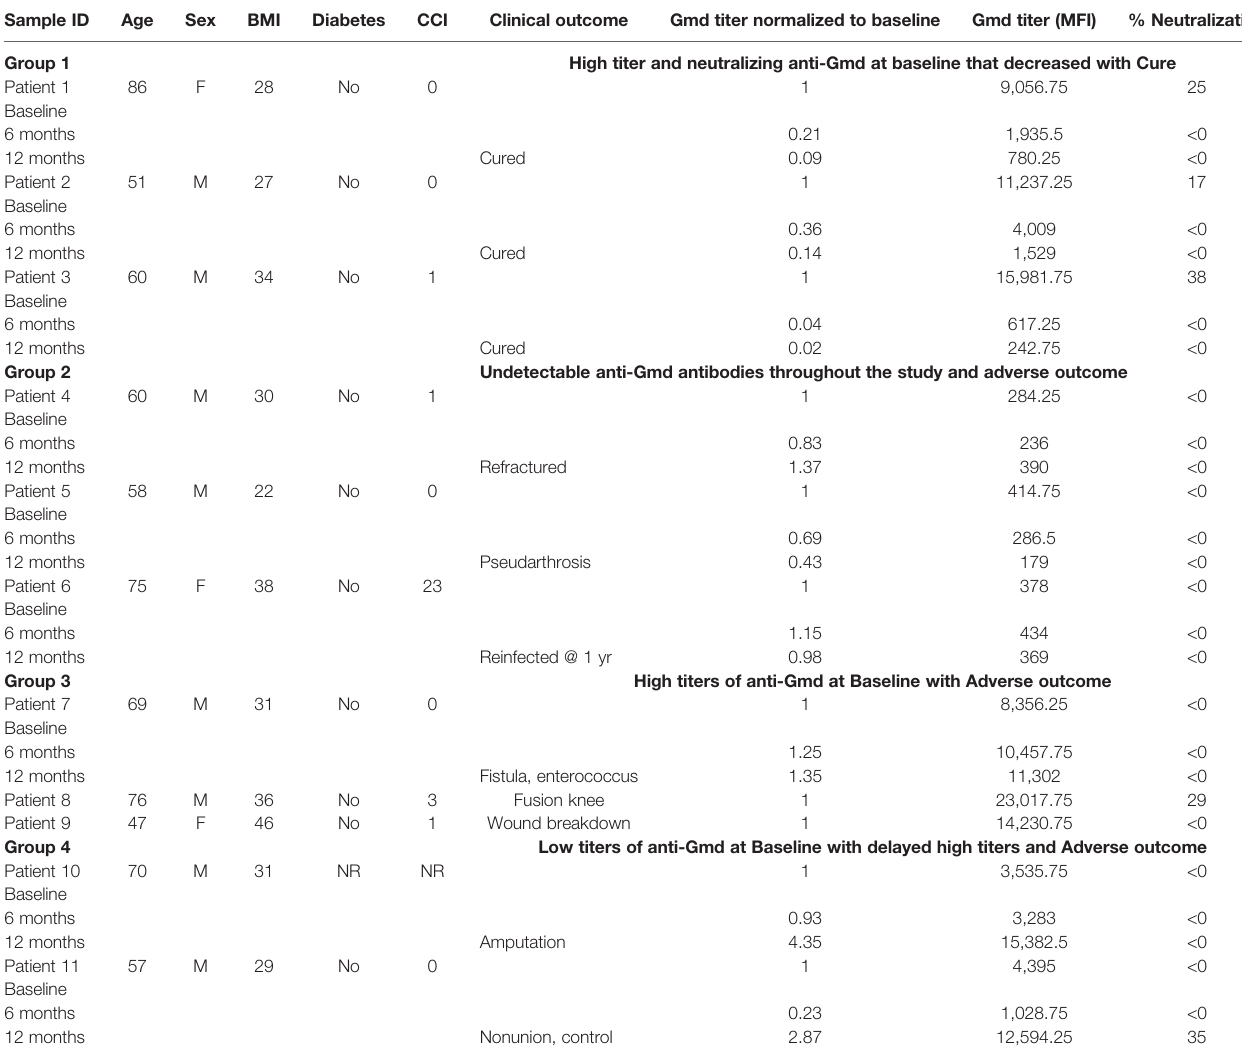
TABLE 1 | Categorical clinical outcomes and anti-Gmd responses. Sample